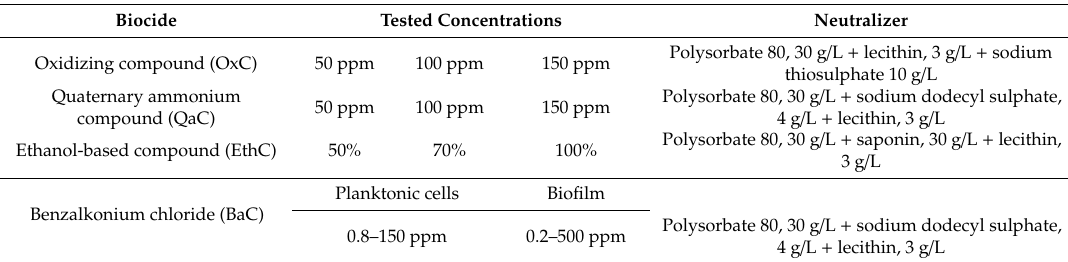
Table 5. Tested biocides, concentration range and neutralizers used in biocide activity testing assay (EN